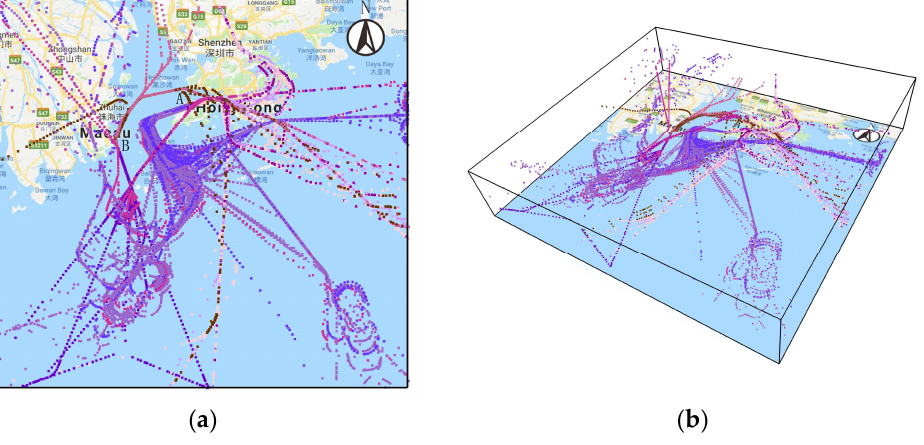
Figure 5. Trajectories of flights on 12 December, 2017, shown in ( a ) a traditional 2D map and ( b ) a 3D data cube.